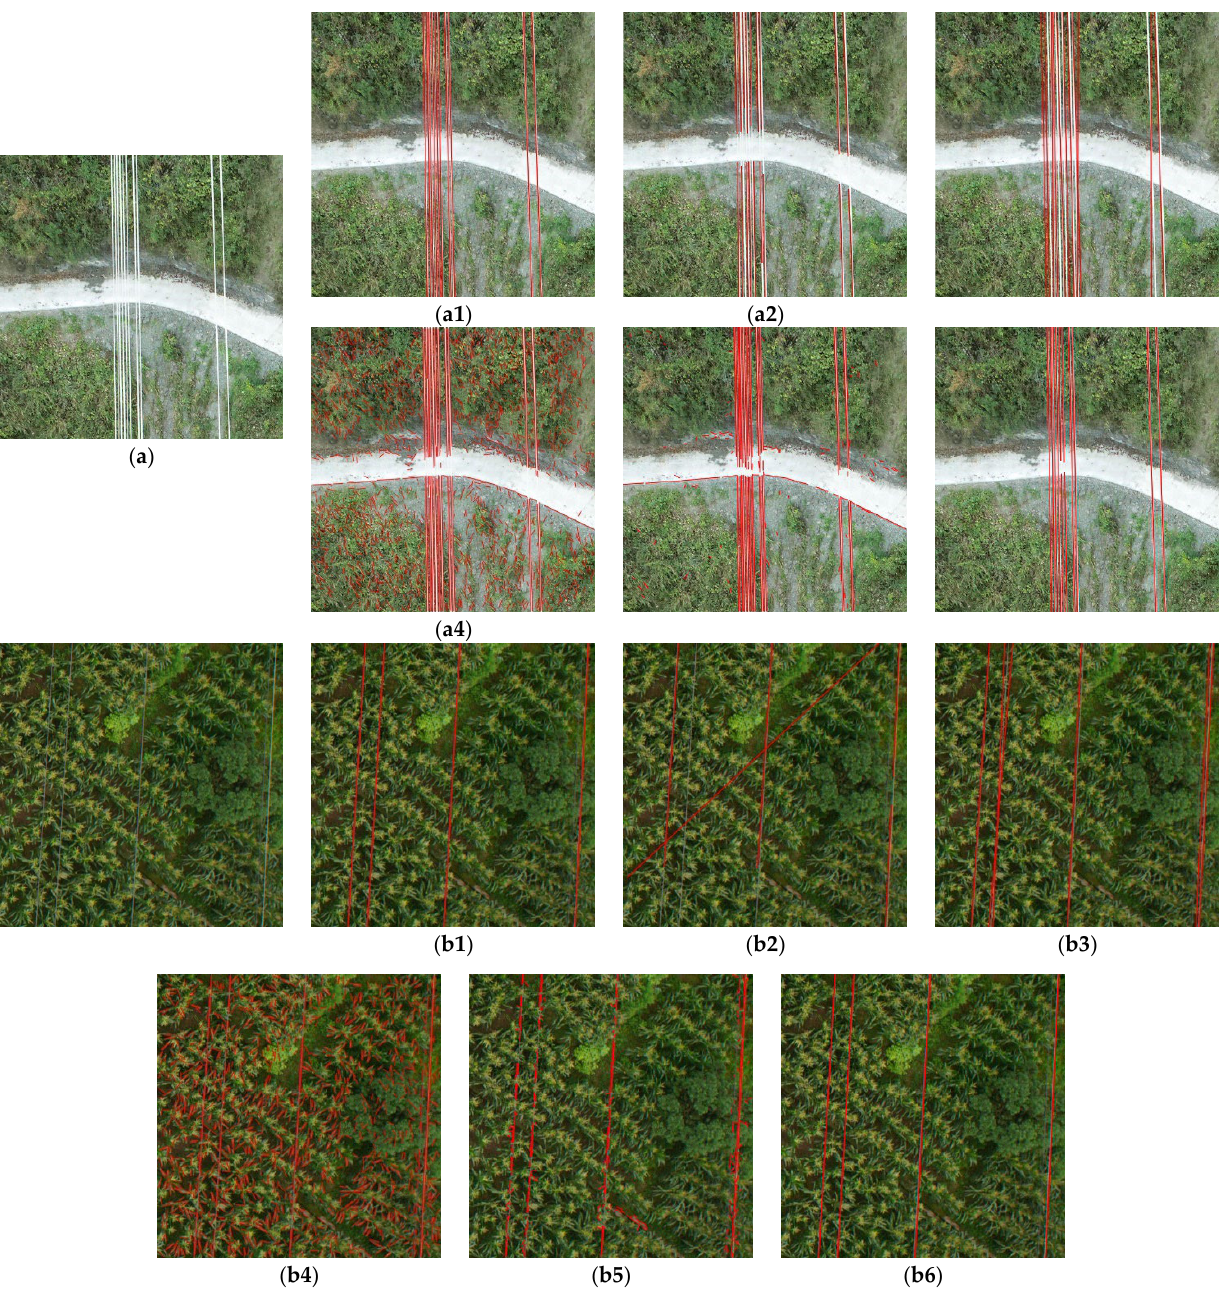
Figure 15. Extraction results for medium IC images: ( a , b ) are the original images; ( a1 , b1 ) are the ground truth; ( a2 , b2 ) are the results of the IHT method; ( a3 , b3 ) are the results of the CRT method; ( a4 , b4 ) are the results of the OLSD method; ( a5 , b5 ) are the results of the LSD-OMRF method; and ( a6 , b6 ) are the final fitting results of the method proposed in this paper.